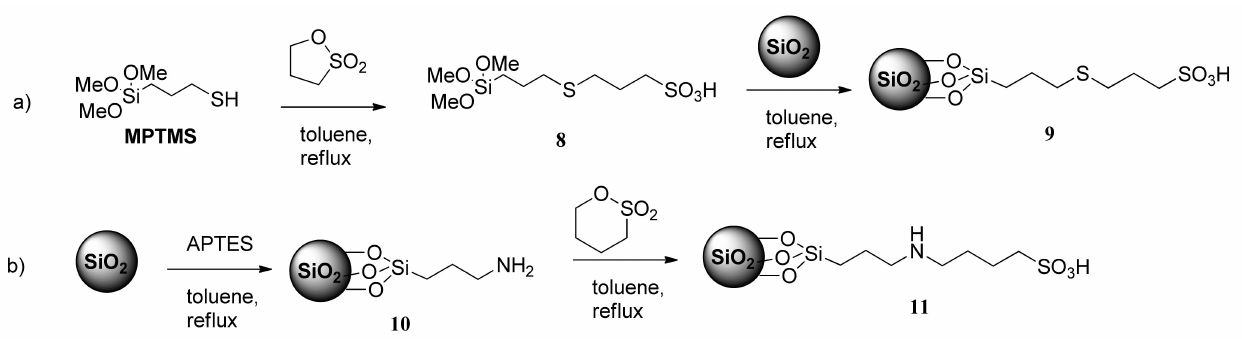
Figure 4. Use of sultones for the synthesis of long chain sulfonic materials containing S (route ( a )) and NH (route ( b )) based on the refs